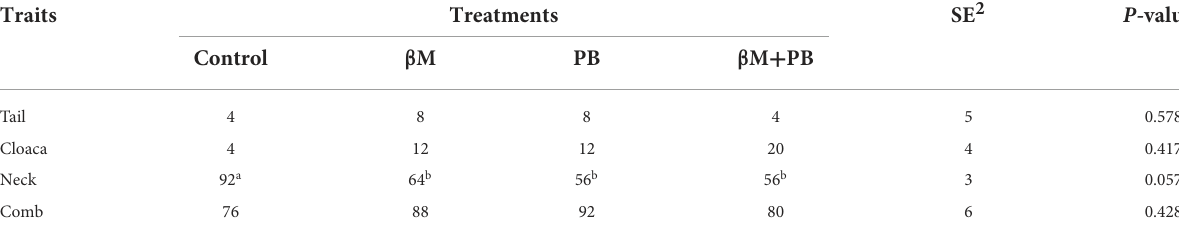
TABLE 5 Frequency (%) of birds with lesions (disregarding the score) observed in groups of laying hens fed β -mannanase and/or probiotics¹. Traits